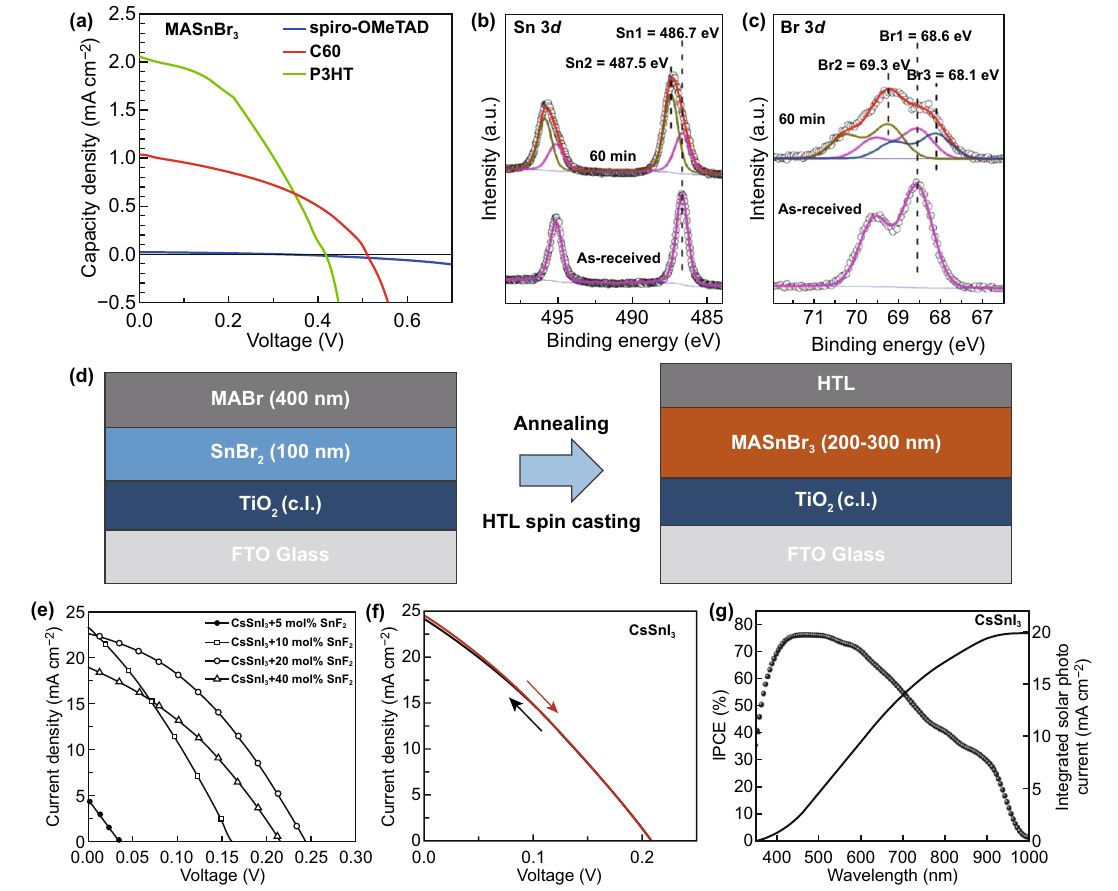
Fig. 4 a J – V curves of co-evaporated MASnBr 3 films with different hole transport materials. b Sn 3d and c Br 3d XPS results of MASnBr 3 films as-deposited and after 1 h stored in air. d Fabrication of sequential method for MASnBr 3 films. Reproduced with permission from Ref. [77]. e J – V curves of CsSnI 3 -based PSCs incorporated with different ratios of SnF 2 . f J – V curves of 20 mol % SnF 2 -doped CsSnI 3 devices show- ing no hysteresis. g IPCE spectrum for 20 mol % SnF 2 -doped CsSnI 3 devices. Reproduced with permission from Ref.